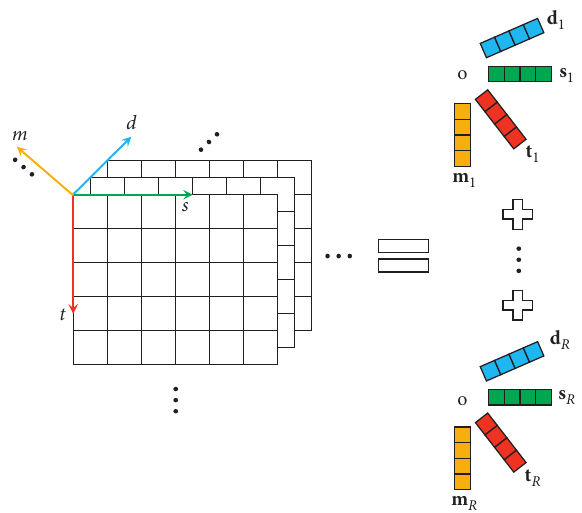
Figure 5: CP decomposition of the MRF flow volume